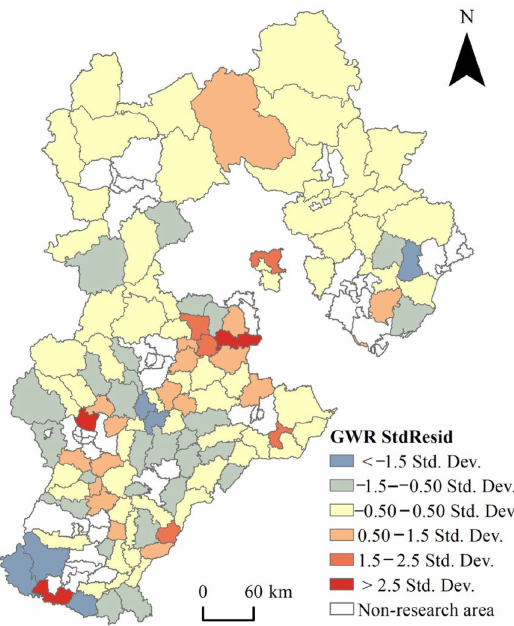
Figure 6. Standardized residuals of the GWR.